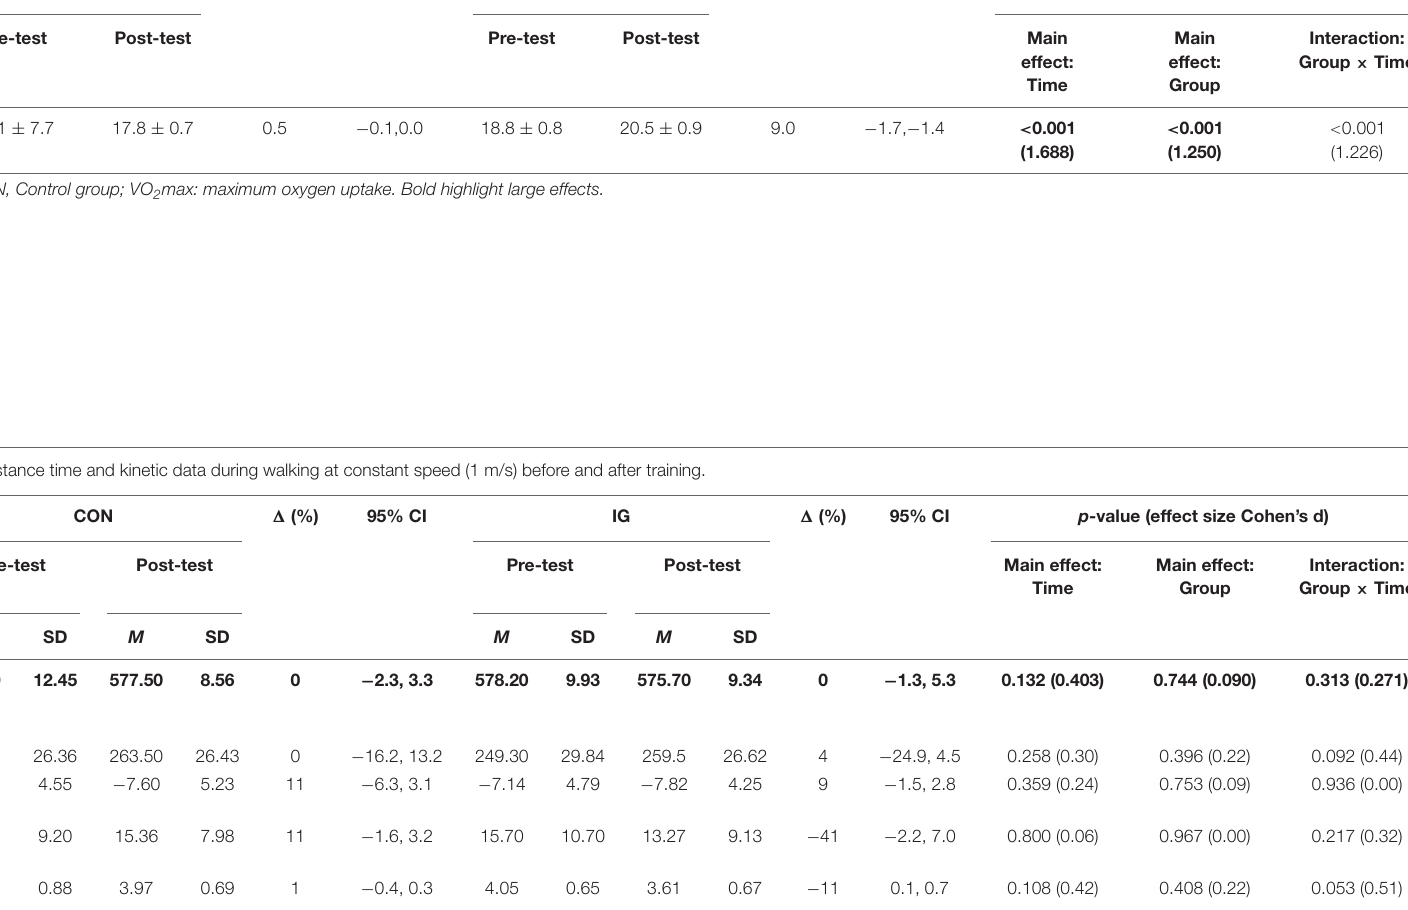
Main Interaction: effect: effect: Group × Time Time Group